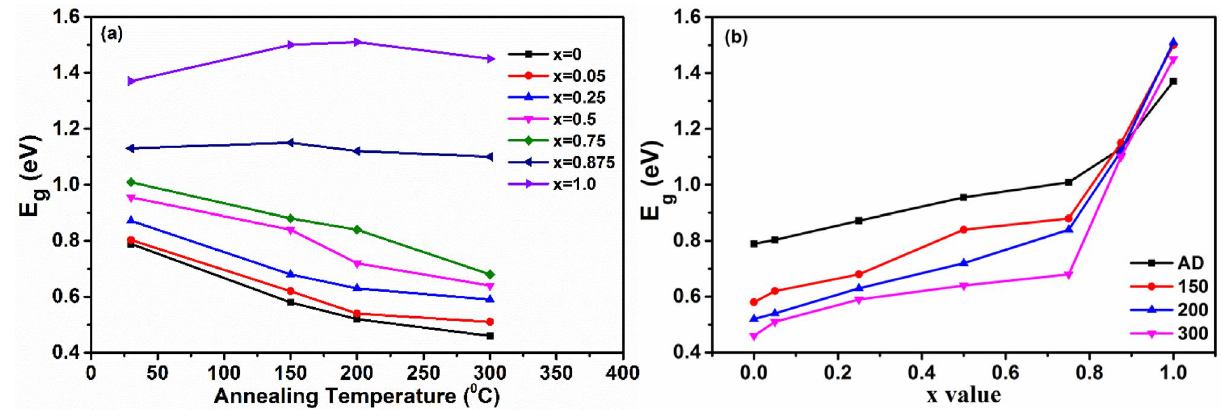
Figure 7. ( a ) Bandgap as a function of annealing temperature. ( b ) Bandgap variation with Se content for different annealing temperatures.